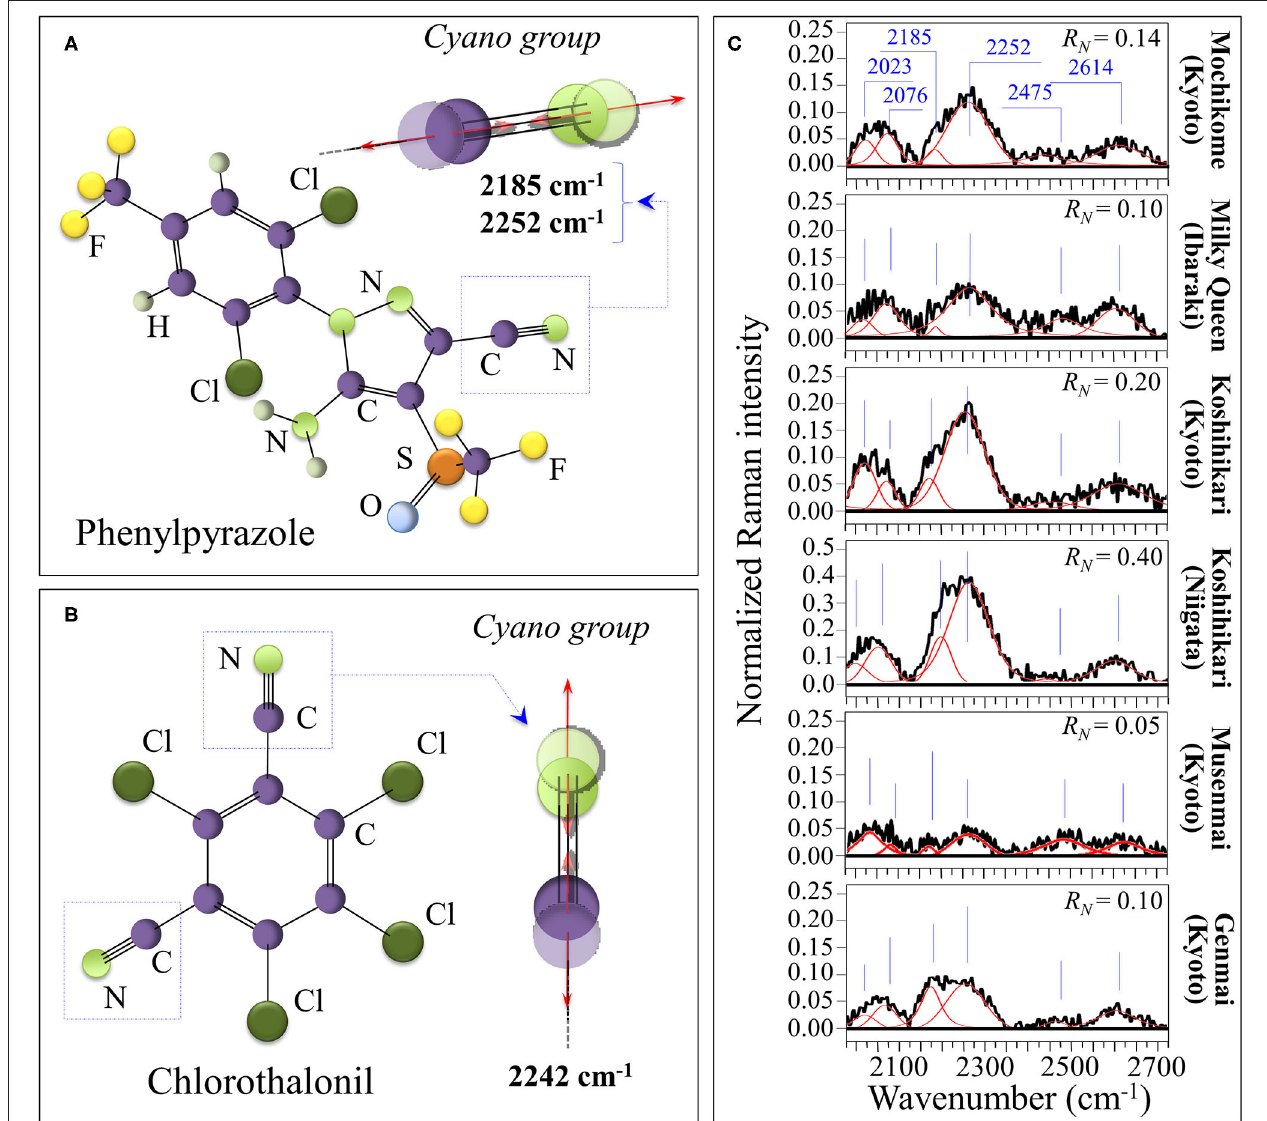
FIGURE 7 | Schematic drafts and C=N stretching vibrations in phenylpyrazole (A) and chlorothalonil (B) residue from crop pesticides; in (C) , Raman spectra of the six investigated cultivars in the spectral region 2,000–2,700 cm − 1 . The clear detection of the doublet at 2,185 and 2,252 cm − 1 proves the presence of nitrile units, which was quantified according to the contaminant ratio, R N = I 2252 / I 478 .